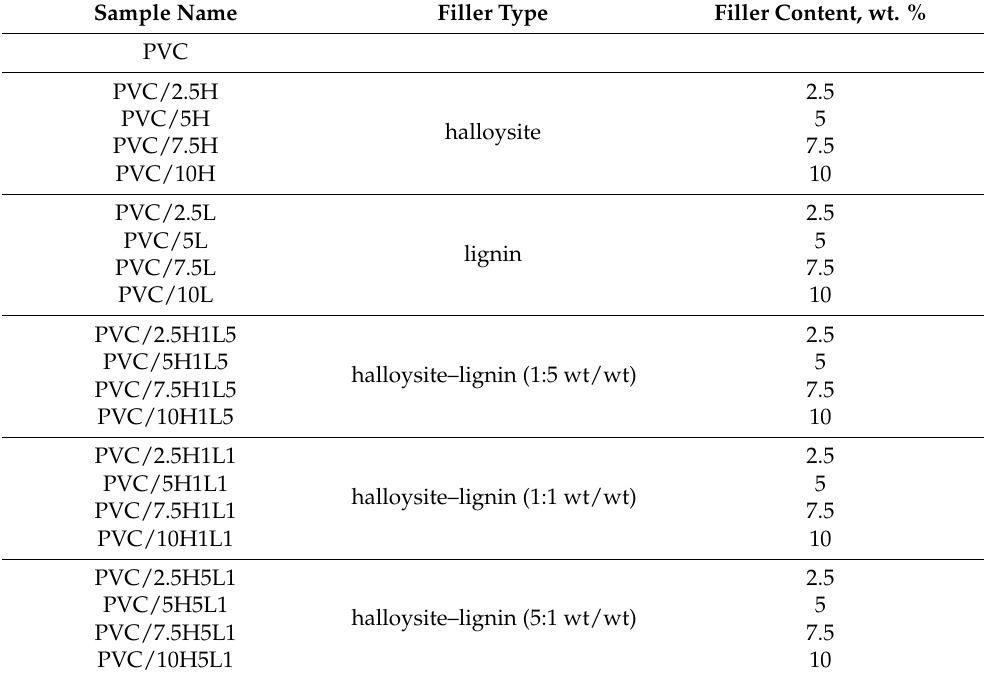
Table 1. Compositions of the PVC-based